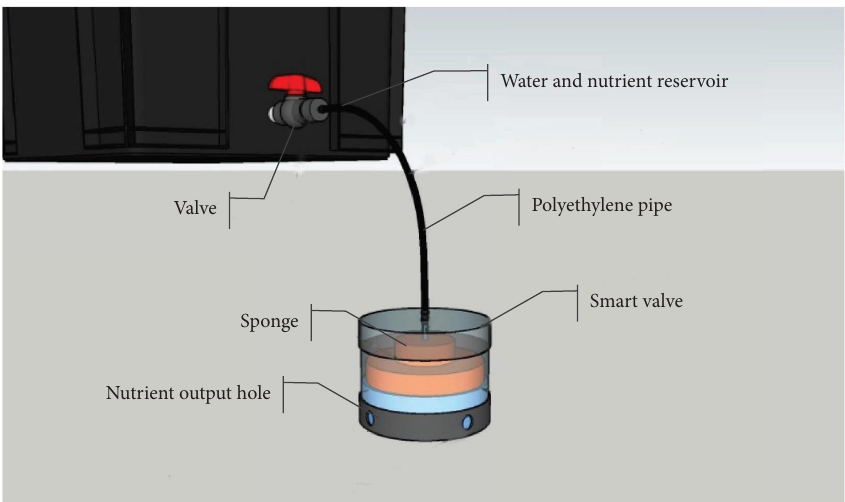
Figure 3: Smart valve components in the self-fertigation system.